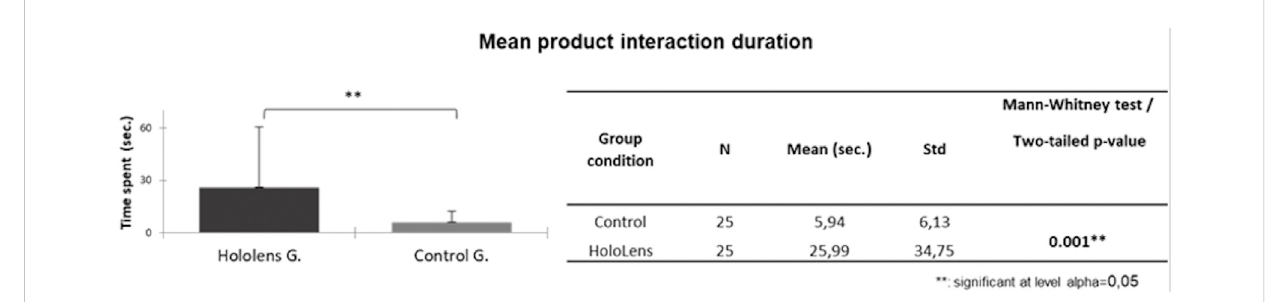
FIGURE 2 Between-group comparisons of mean time spent interacting with